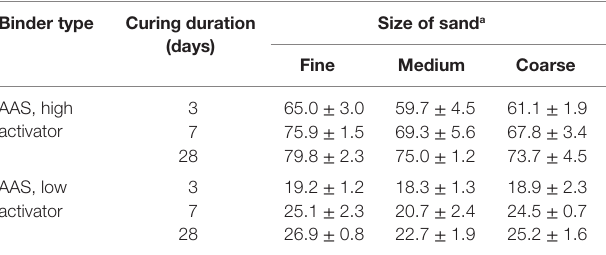
TaBle 2 | compressive strengths (MPa) of mortars; data are presented as the mean and sD of three replicate samples. Binder type curing duration size of sand a (days)